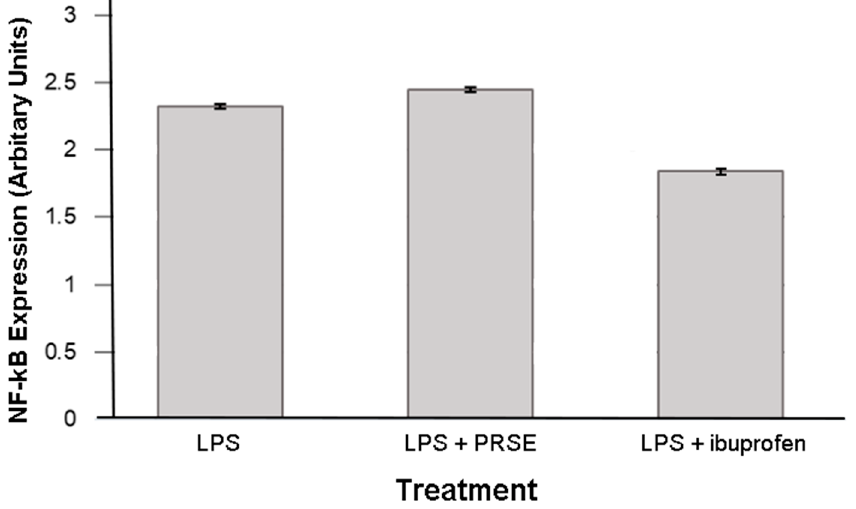
Figure 4. Expression of NF- κ B after 24 h treatment.